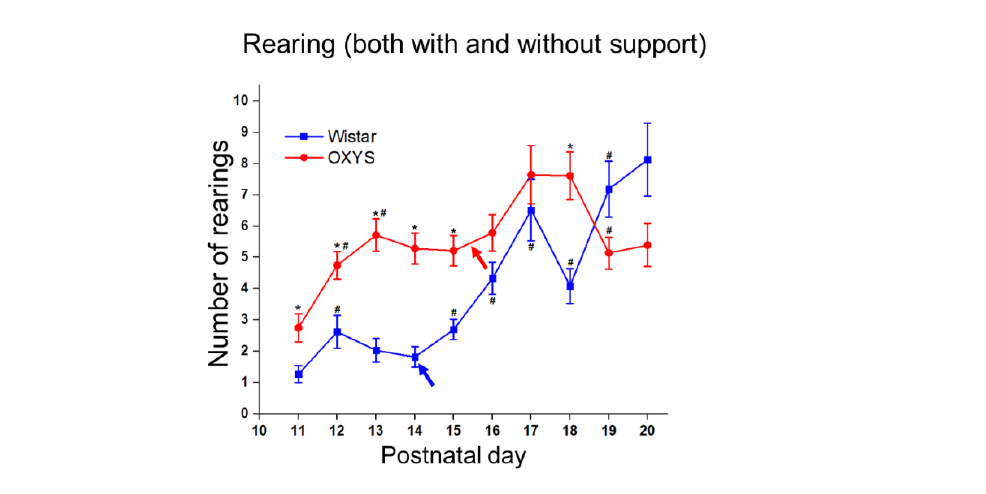
Figure 4. Exploratory activity of OXYS and Wistar pups. * p < 0.05 as compared to control (Wistar) rats; # p < 0.05 as compared to a previous day; blue arrow: eye opening in Wistar pups; red arrow: eye opening in OXYS pups. The data are presented as the mean ± SEM.